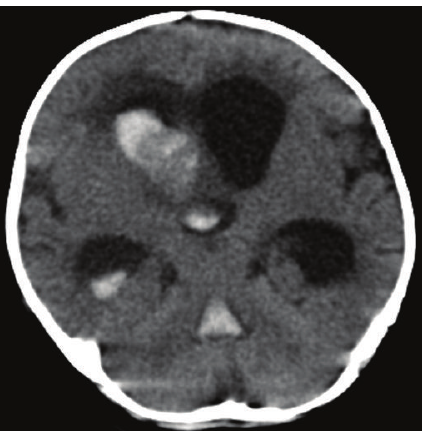
Figure 1: Cranial preoperative CT-scan: tetraventricular hemor- rhage (Fisher 4) and acute